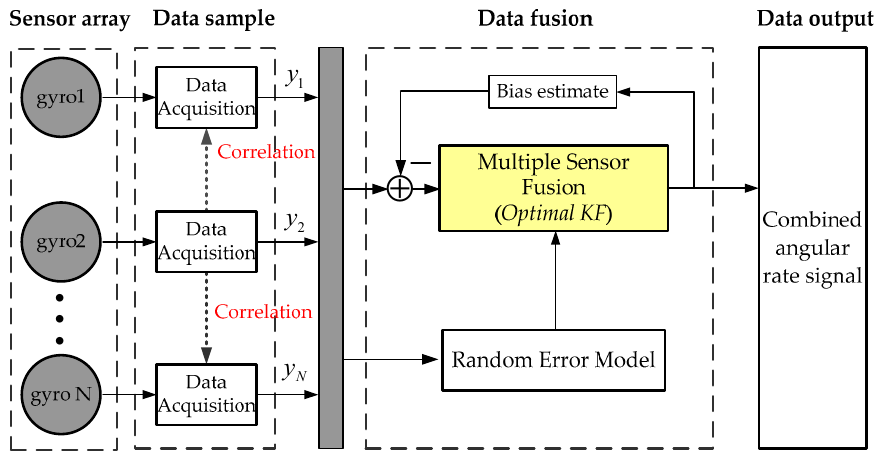
Figure 1. Principle of the multiple rate signals fusion of a MEMS gyroscope array.